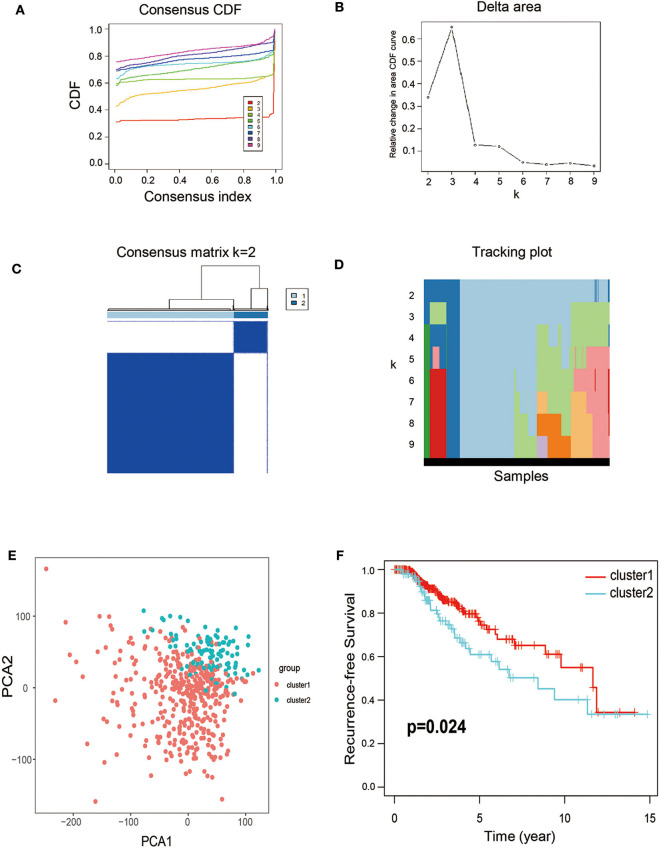
Calculation of consensus clusters by 77 DEGs. (A) Consensus clustering cumulative distribution function (CDF) of k = 2–9. (B) Relative change in area under CDF curve of K = 2–9. (C) Consensus clustering matrix of k = 2. (D) The tracking plot for k = 2–10. (E) Principal component analysis (PCA) of the overall RNA expression data from TCGA-THCA. (F) Recurrence-free survival between the two clusters from TCGA-THCA (p = 0.024).